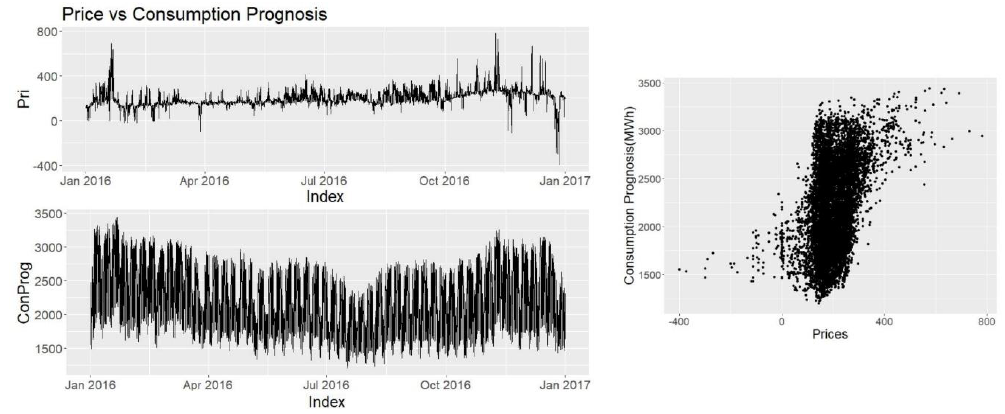
Figure 9. Price vs. Consumption prognosis.